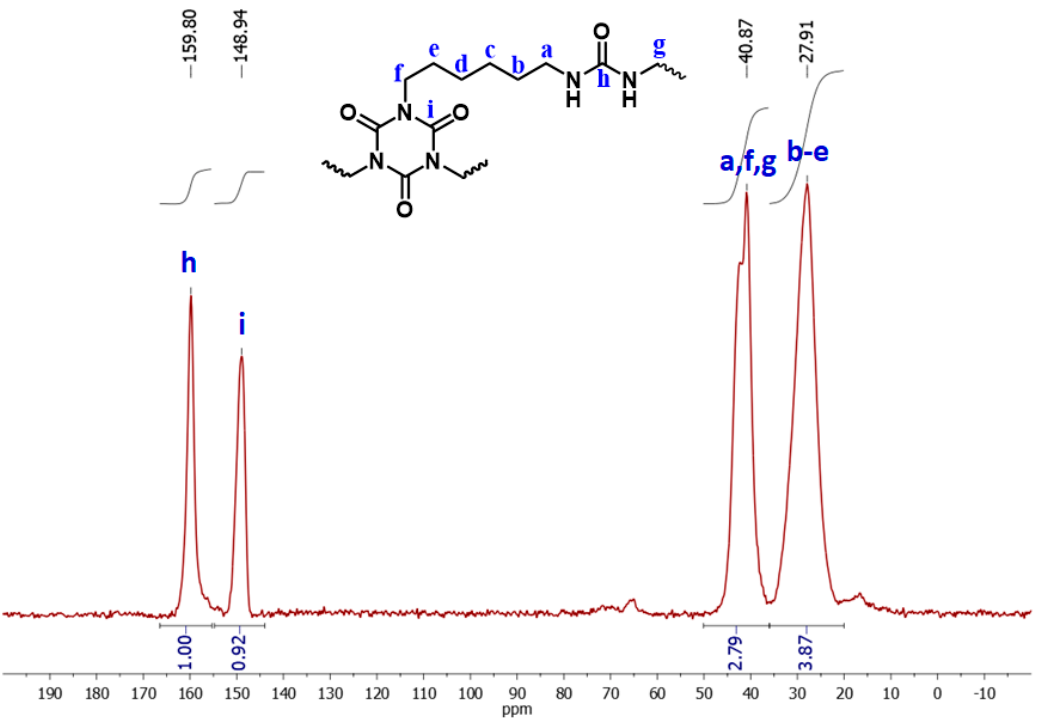
Figure 6. 13 C cross-polarization magic angle spinning (CPMAS) NMR spectrum of spherical PUA aerogel beads.